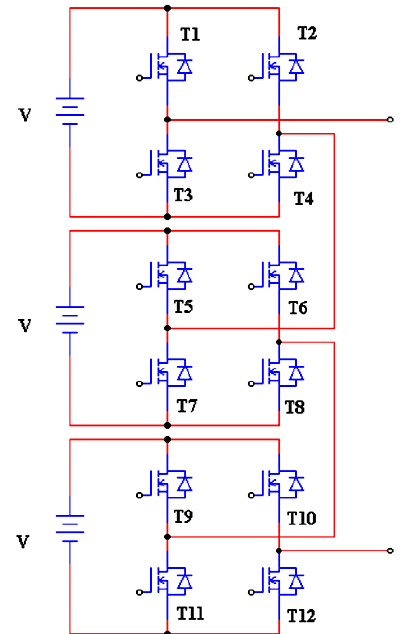
Figure 51. Circuit diagram for cascade H-bridge inverter.